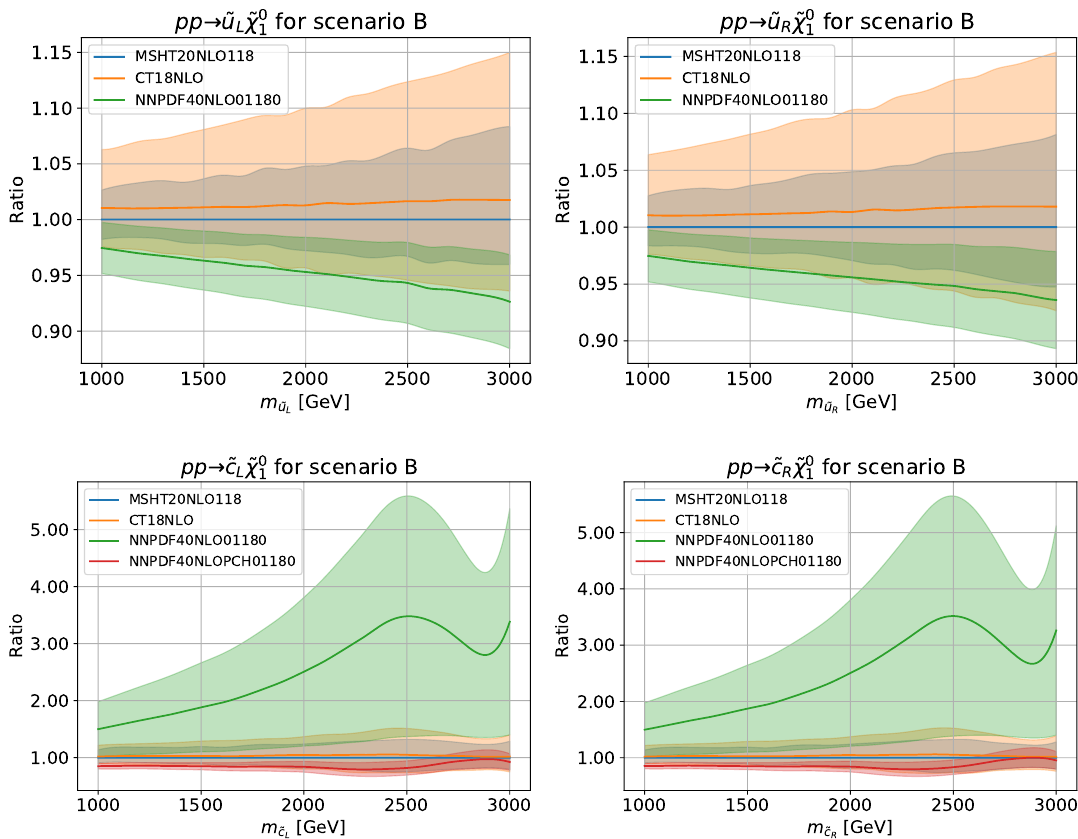
Figure 6. Relative PDF uncertainties of the total cross sections for the processes pp → ˜ q L,R ˜ χ 0 √ LHC with a centre-of-mass energy of S = 13 TeV and at NLO+NLL. The uncertainties are shown as a function of the squark mass m ˜ q and for four different choices of PDFs, namely MSHT20NLO118 L,R (blue), CT18NLO (orange), NNPDF40NLO01180 (green) and NNPDF40NLOPCH01180 (red).